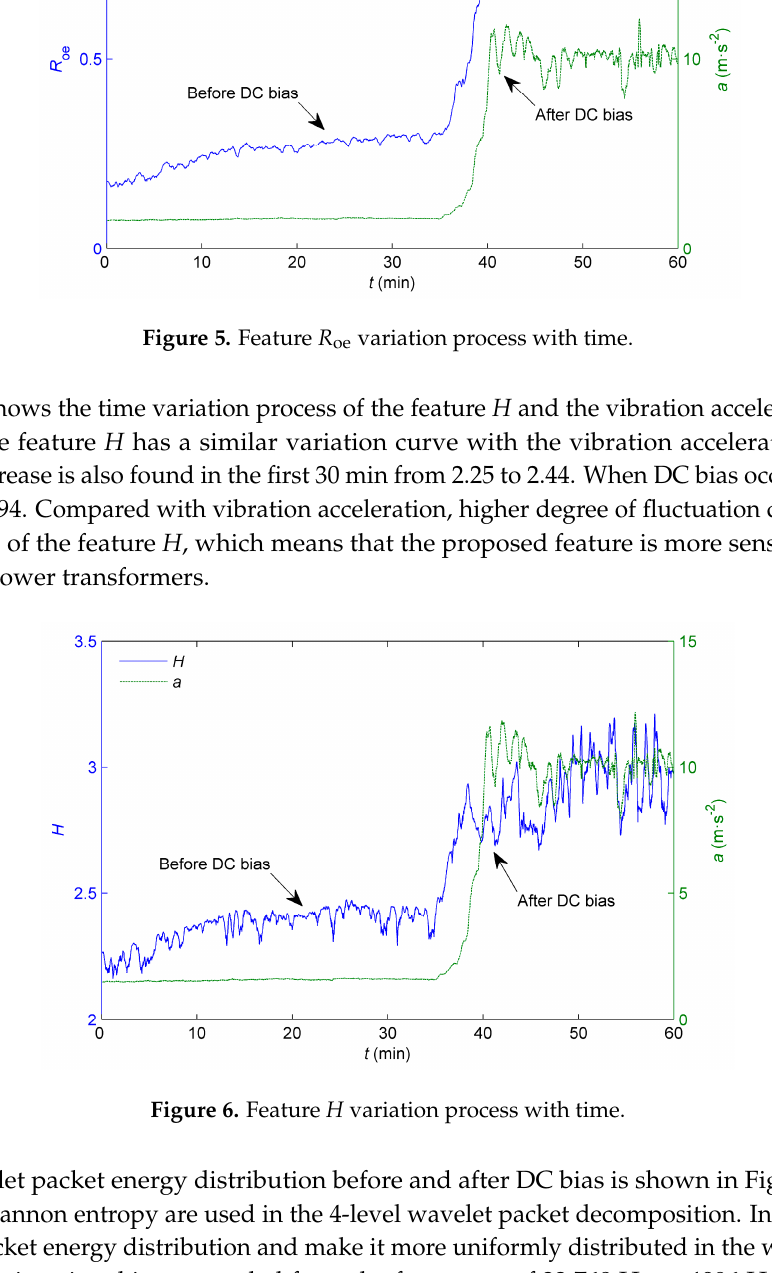
Figure 5. Feature R oe variation process with time.